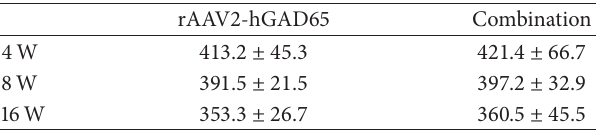
Table 3: The number of the hGAD65-positive neurons in STN. rAAV2-hGAD65 Combination 4 W 413.2 ± 45.3 421.4 ± 66.7 8 W 391.5 ± 21.5 397.2 ± 32.9 16W 353.3 ± 26.7 360.5 ± 45.5 There were no significant differences between rAAV2-hGAD65 group and combination group at 4, 8, and 16 weeks after treatment, respectively ( 𝑃